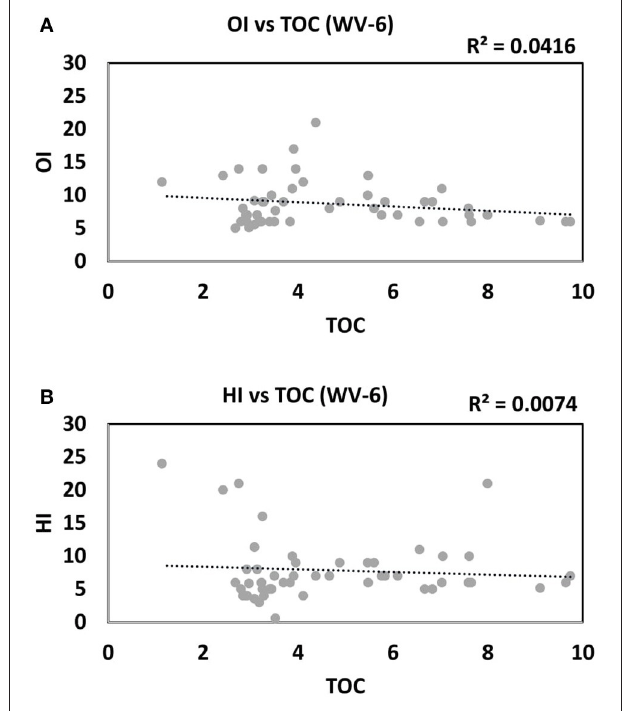
FIGURE 9 | (A) HI vs. TOC and (B) OI vs. TOC plots for WV-7 samples.